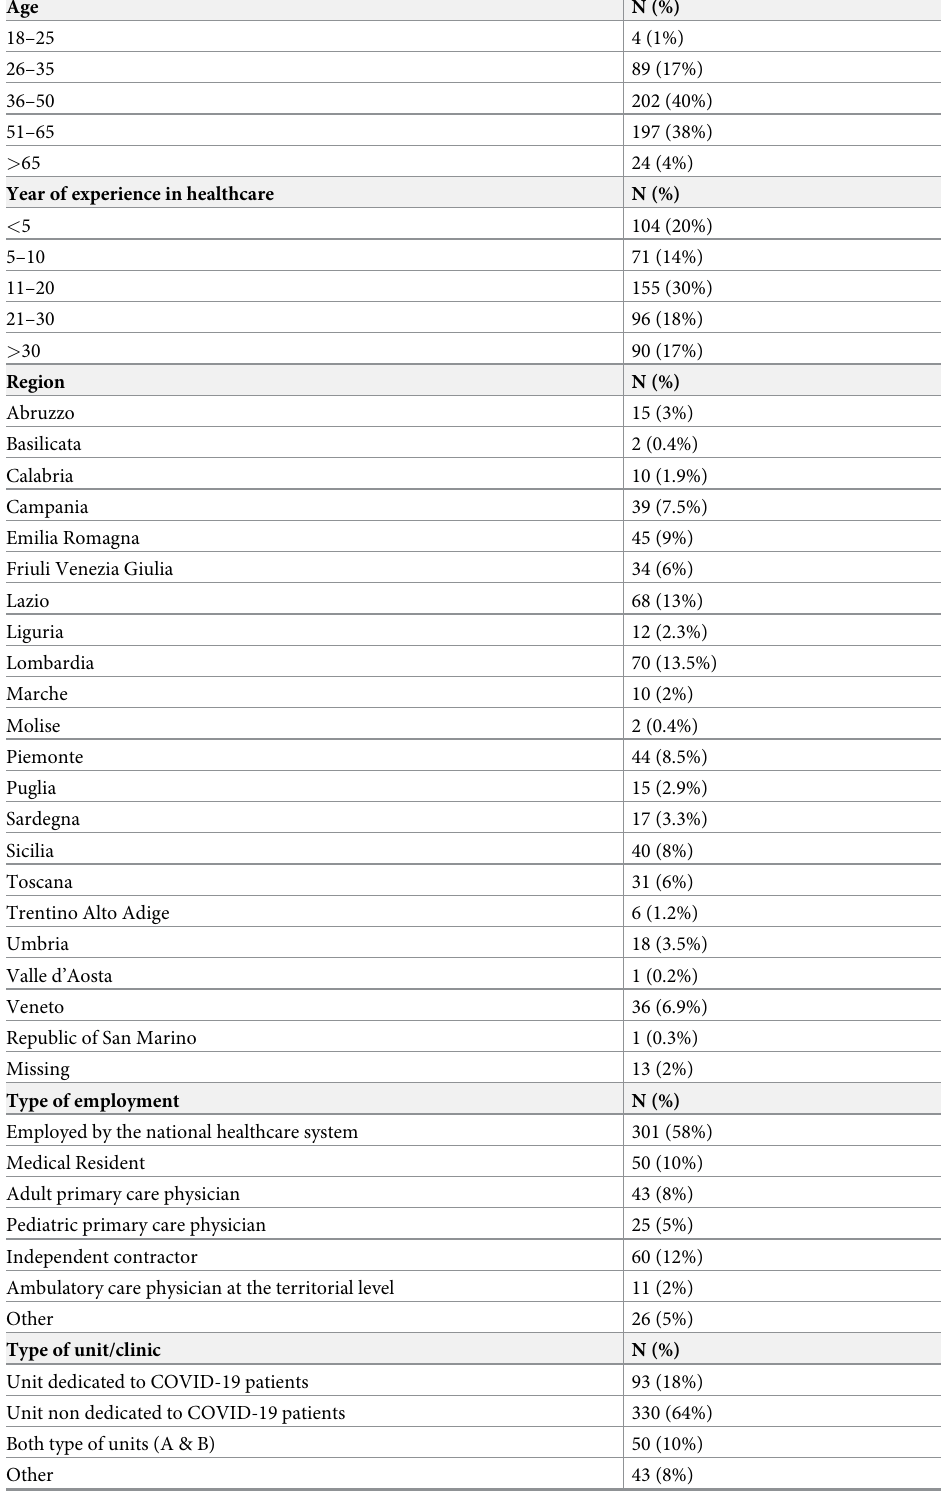
Table 2. Respondents’ characteristics (n =